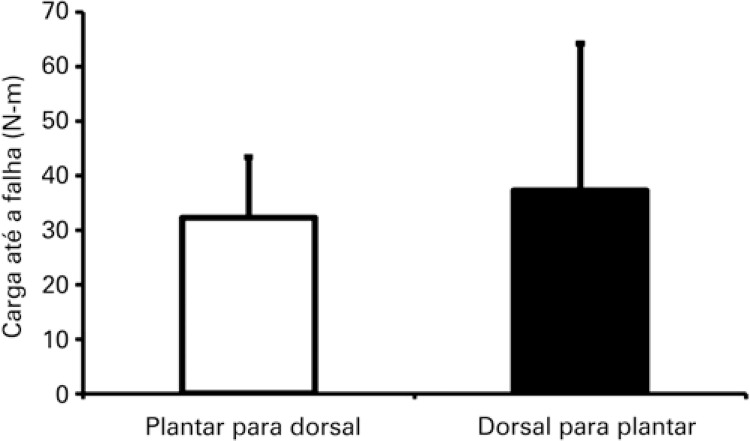
Comparação das cargas até a falha entre as fixações plantar para dorsal e dorsal para plantar